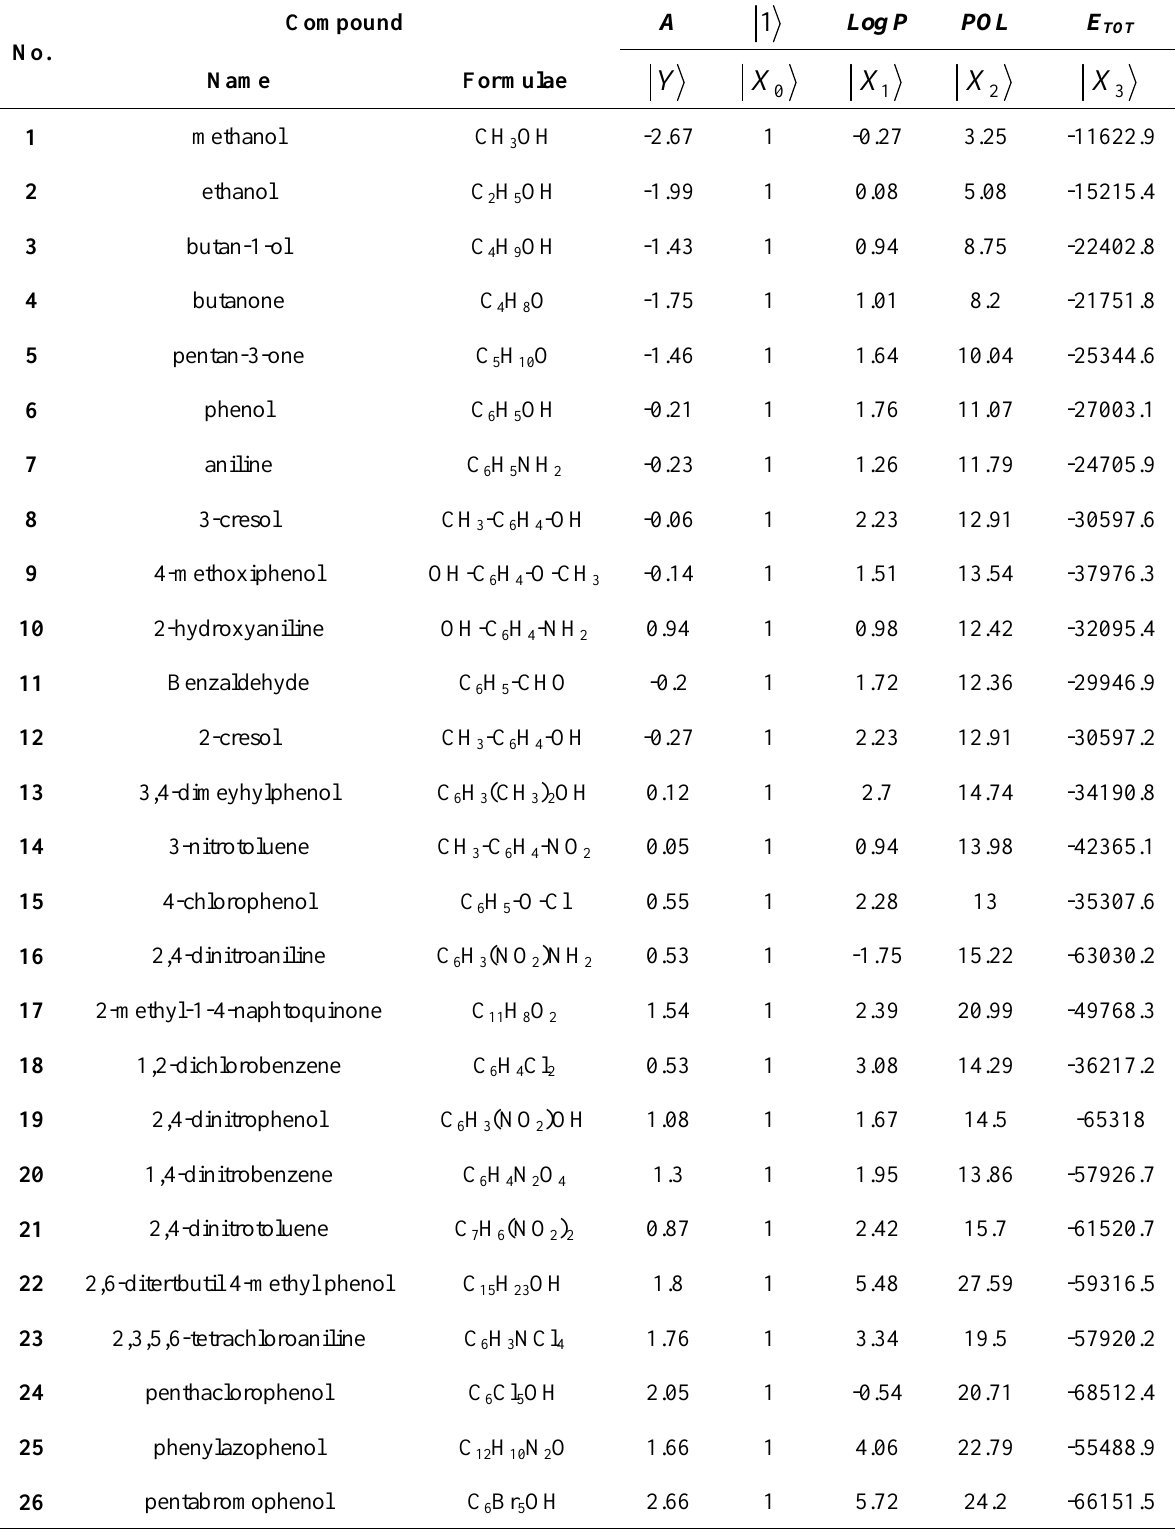
Table 3. The series of the xenobiotics of those toxic activities A = Log(1/IGC ) were considered [86] 50 along structural parameters LogP , POL (Å 3 ), and E (kcal/mol) as accounting for the hydrophobicity, TOT electronic (polarizability) and steric (total energy at optimized 3D geometry) effects, respectively, derived with the help of HyperChem program